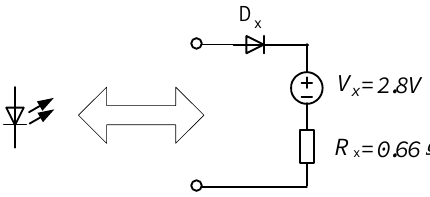
Figure 6. Single LED model parameter.